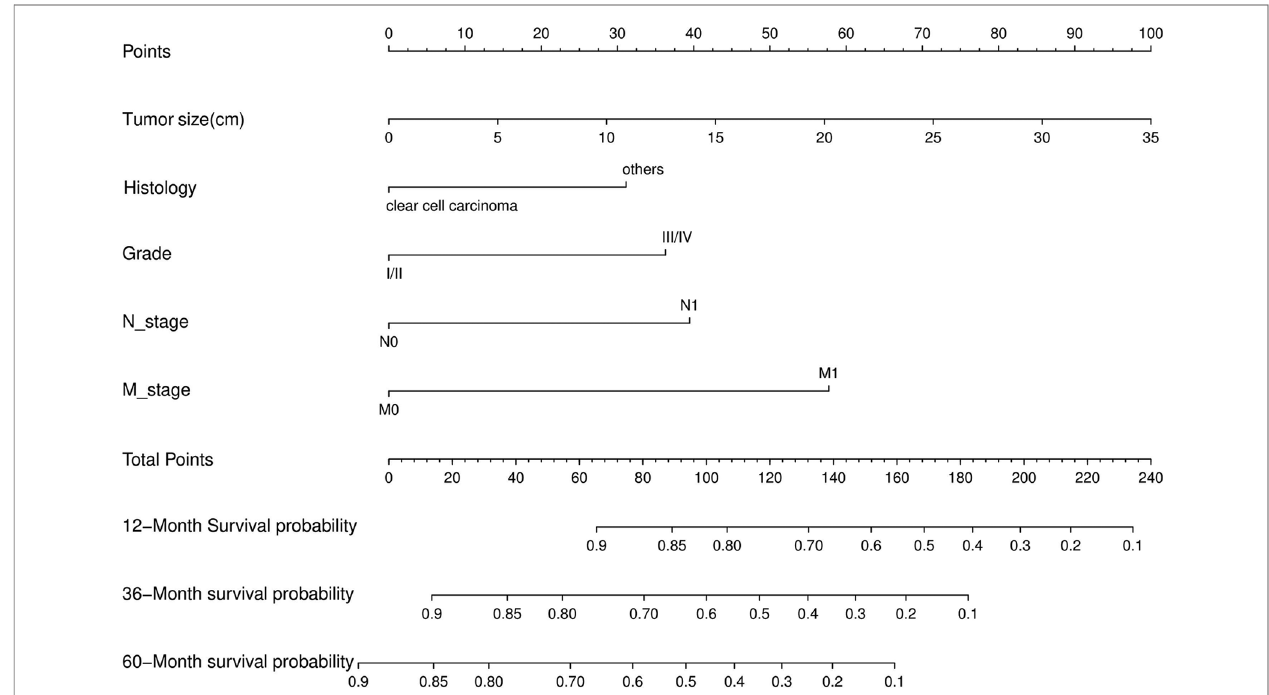
FIGURE 1 | Nomogram for predicting postoperative CSS in patients with renal cell carcinoma complicated with venous tumor thrombus.